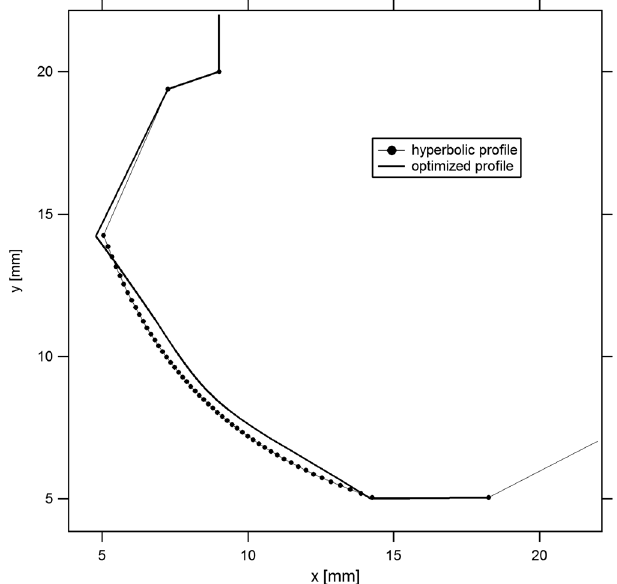
FIG. 6. Hybrid quadrupole pole shape before and after